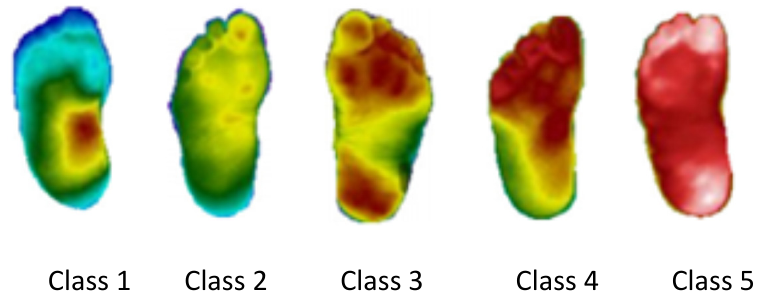
Figure 3. Classification of 5 thermograms of diabetic individuals Figure 2 . Classification of 5 thermograms of diabetics individuals.